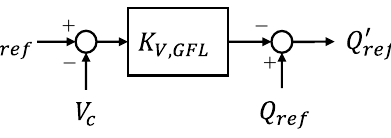
Figure 7. Reactive power controller optionally embedded in the GFL-type controller for voltage regulation.